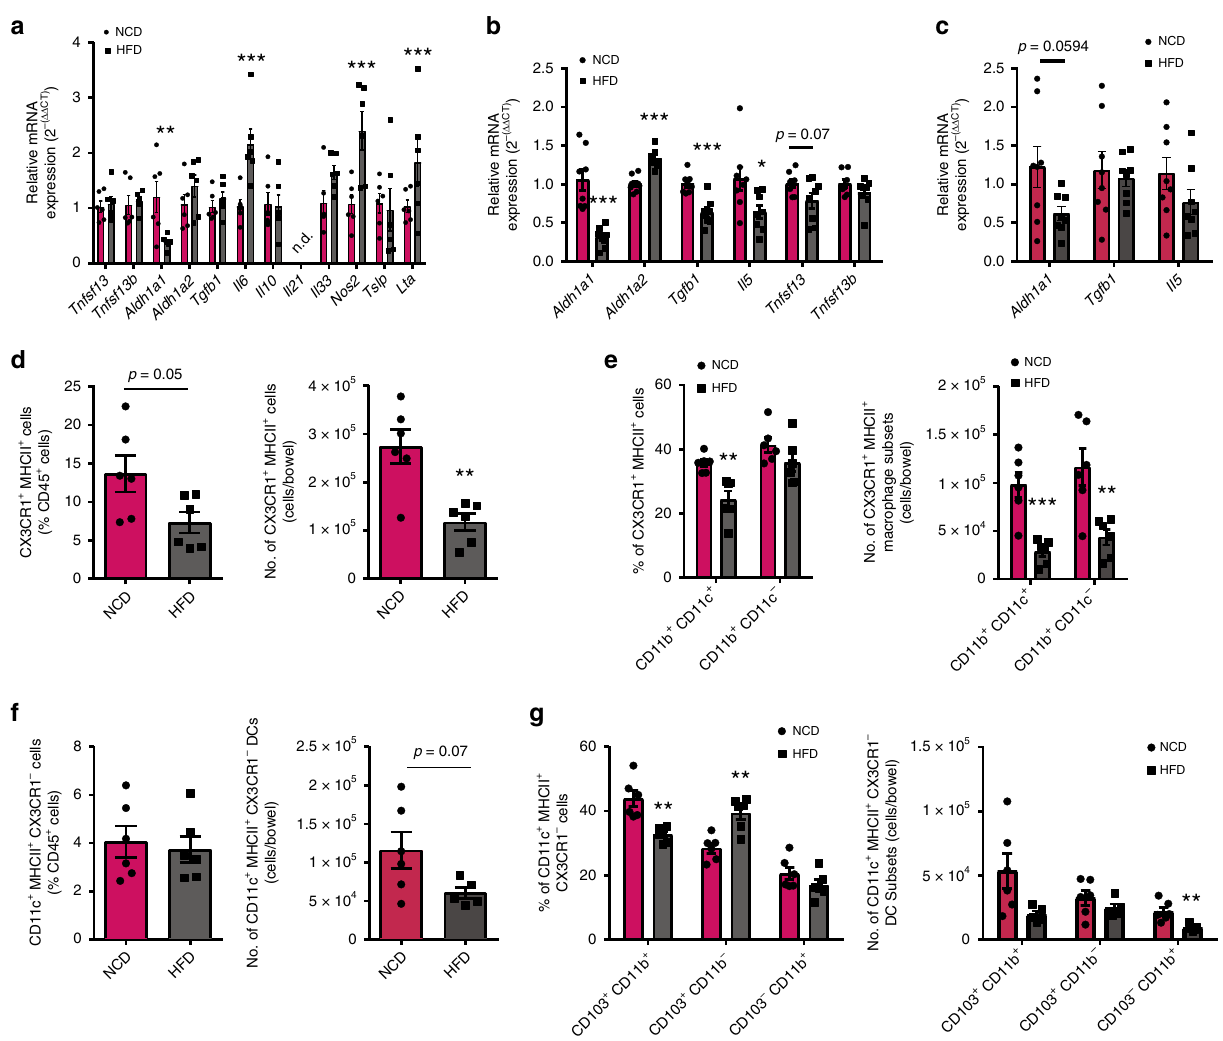
Fig. 2 High fat diet (HFD) feeding impedes secreted factors and immune cells promoting intestinal immunoglobulin A (IgA). Relative messenger RNA (mRNA) expression of genes promoting IgA in colon a whole tissue ( n = 6/group), b lamina propria (LP) ( n = 8/group, 2 experiments), and c epithelial cell fraction ( n = 8/group, 2 experiments) in HFD-fed C57BL/6J mice after 14 weeks compared to normal control diet (NCD) controls. Frequency (left) and absolute number (right) of d CX3CR1 + MHCII + macrophages, e corresponding macrophage subsets, f CD11c + MHCII + CX3CR1 − dendritic cells, and g corresponding dendritic cell subsets in the colonic LP of C57BL/6J mice fed a HFD/NCD for 14 weeks ( n = 6/group, 2 experiments). Data are means ± SEM. * denotes p < 0.05, ** denotes p < 0.01, and *** denotes p <